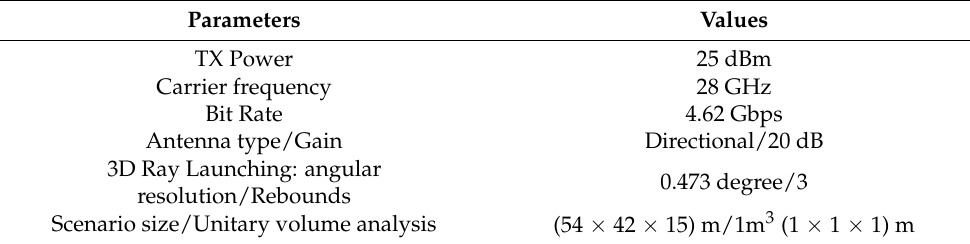
Table 1. RL algorithm simulation